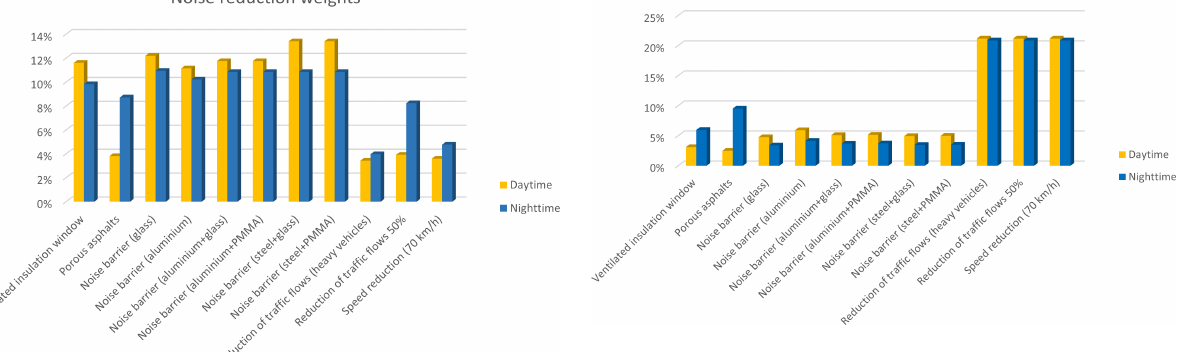
Figure 10: Comparison of economic cost weights in the two scenar-